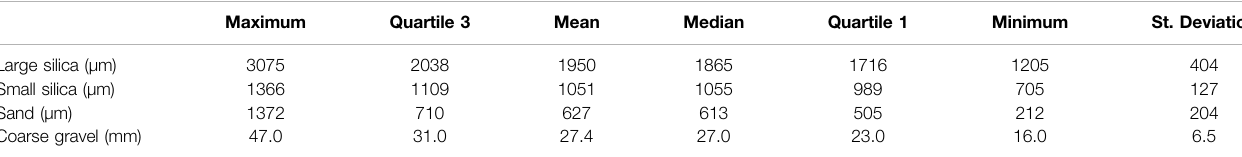
TABLE 3 | General descriptive statistics of the grain size of the porous medium